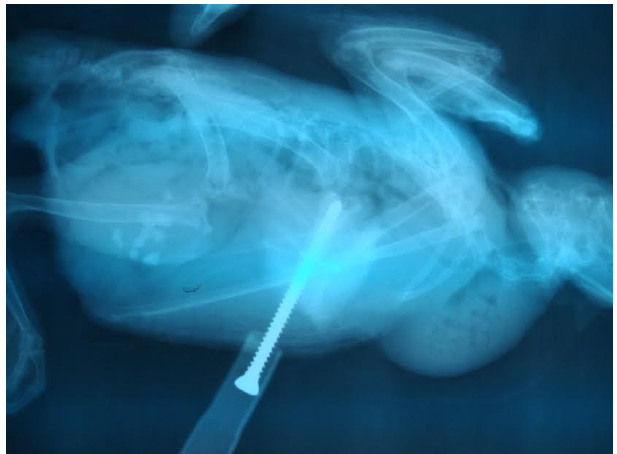
Fig. 5. Radiography showed endoprosthesis and exoprosthesis